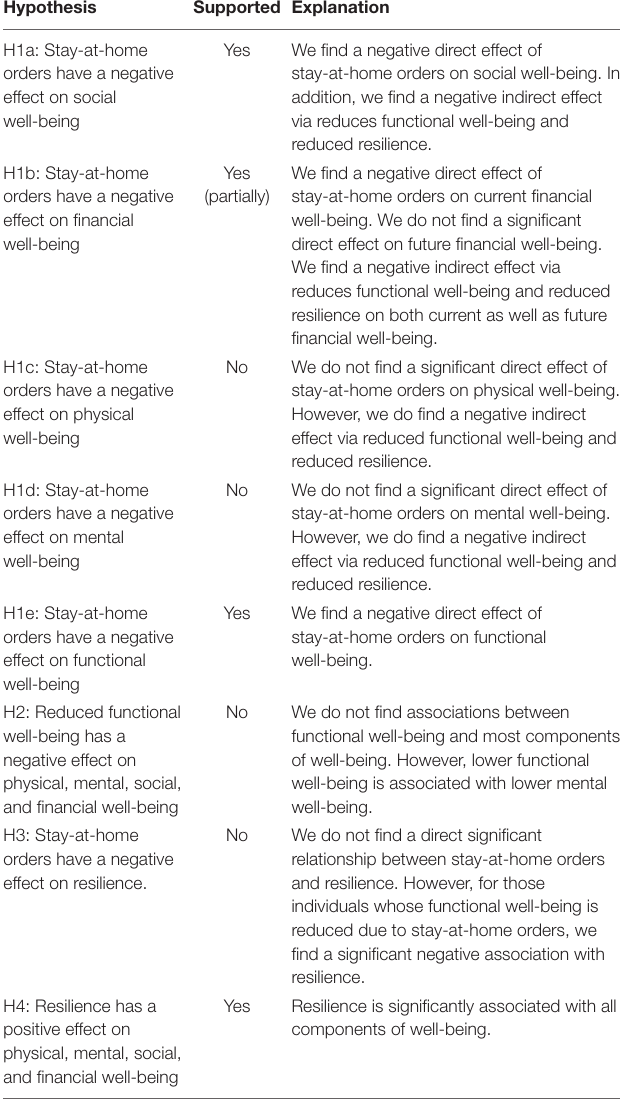
TABLE 5 | Overview of tested hypotheses. Hypothesis